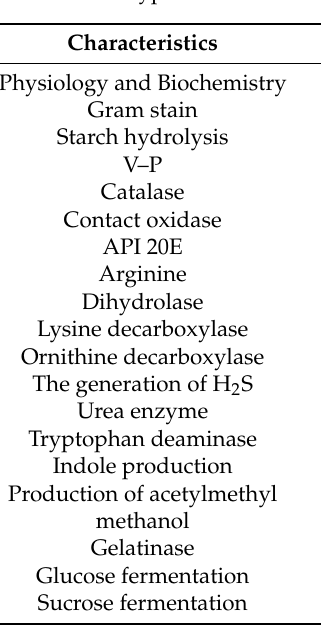
Figure 1. Oil micrograph of the Gram-negative strain TAW-CT127 grown marine 2216 Luria–Bertani agar at 28 °C for 72 h. Table 1. Phenotypic characteristics of strain TAW-CT127.